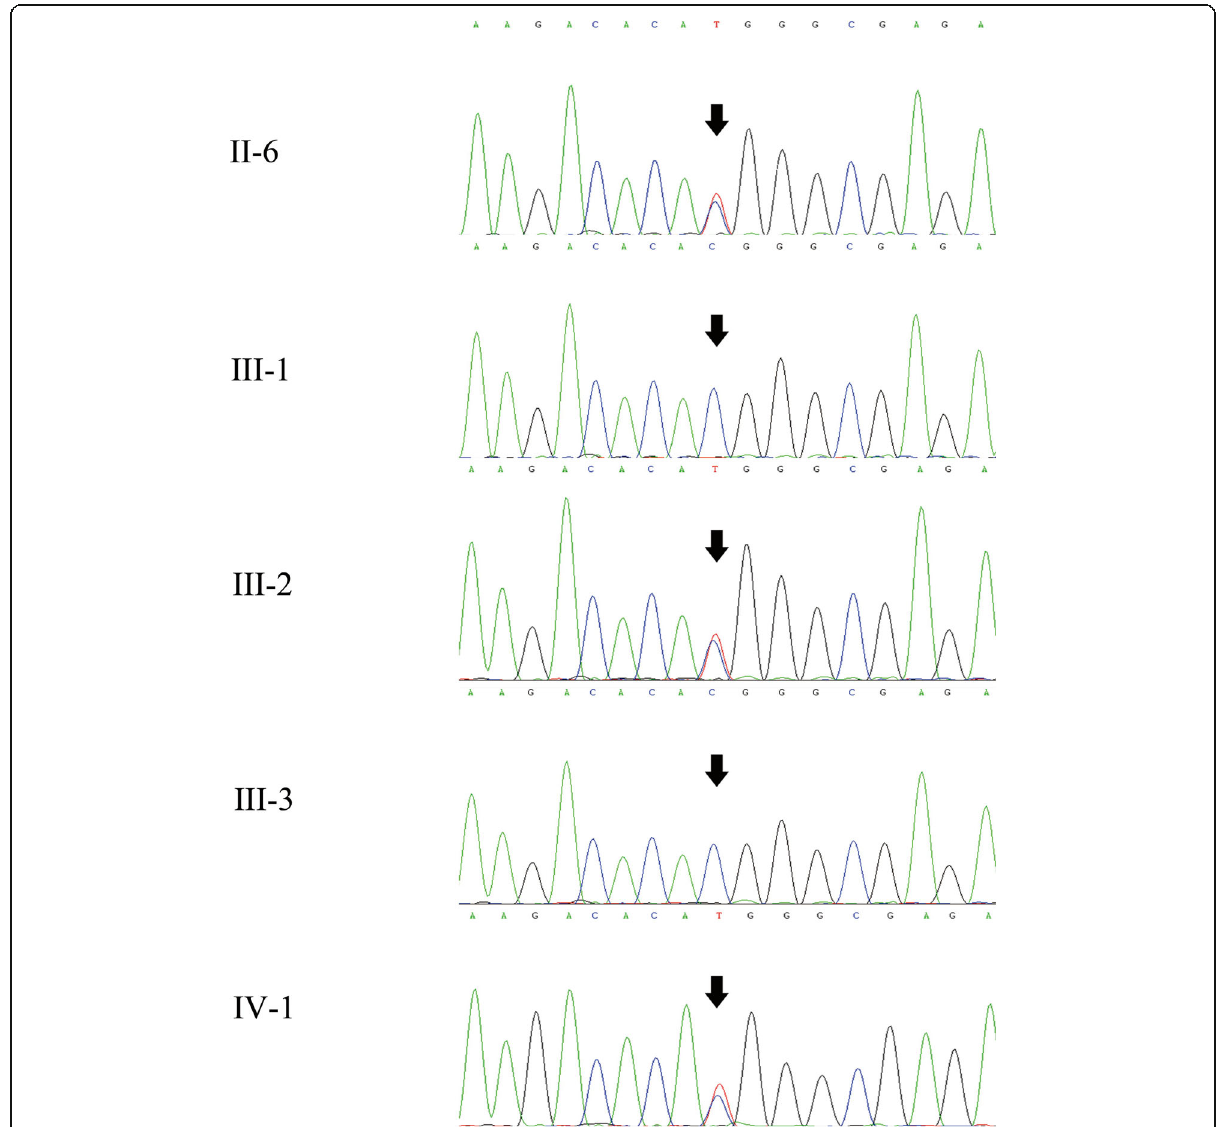
Fig. 2 Sequencing data of the GLI3 gene in the patient and his family. The arrows indicate the position of the c.1622C>T; p.(Thr541Met) substitution